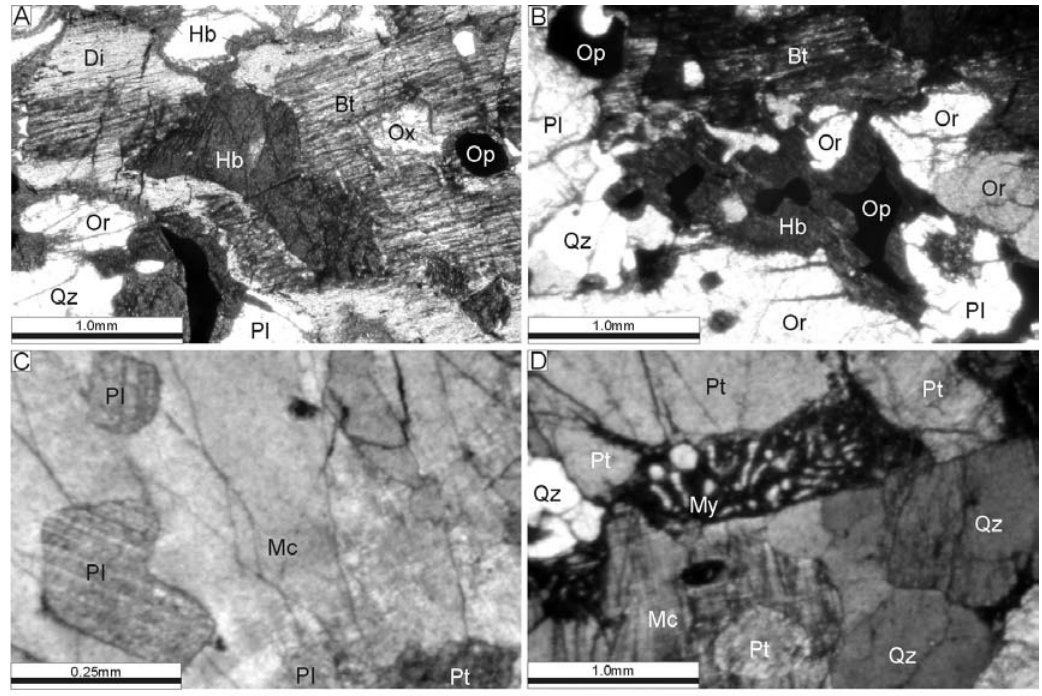
Fig. 5 – Photomicrographs, plane light (a, b) and polarized light (c, d) illustrating microtextural features of the mesosome (a, b, c), leucosome (c, d). Key: Qz = quartz, Pt = perthite, Bt = biotite, Op = opaque, Pl = plagioclase, My = myrmekite, Hb = hornblende, Or = orthoclase, Ox = orthopyroxene, Di = diopside (The scale is indicated in each photomicrograph).